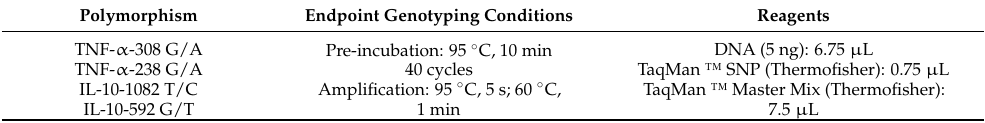
Table 13. Endpoint genotyping conditions and reagents for TNF- α and IL-10